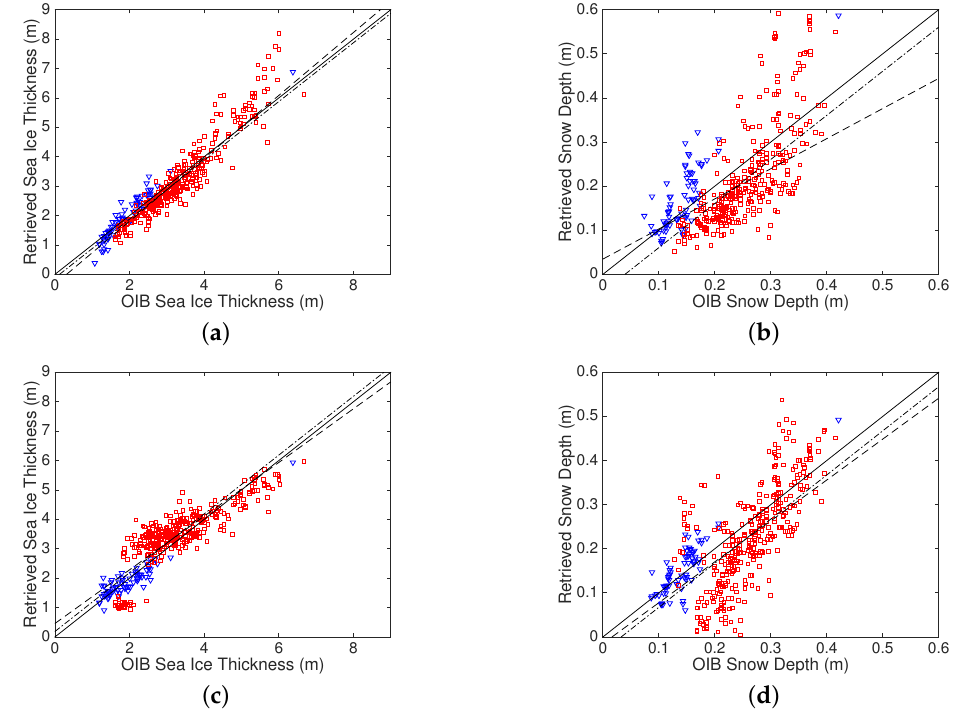
Figure 12. Similar to Figure 11, but limited to points of modeled TB within +/ The ordering of the subfigures are the same as in Figure 11, with ( a , b ) showing the results for hi and hs during the synergy between FB ice and TB , and ( c , d ) the results during the synergy between FB snow and TB